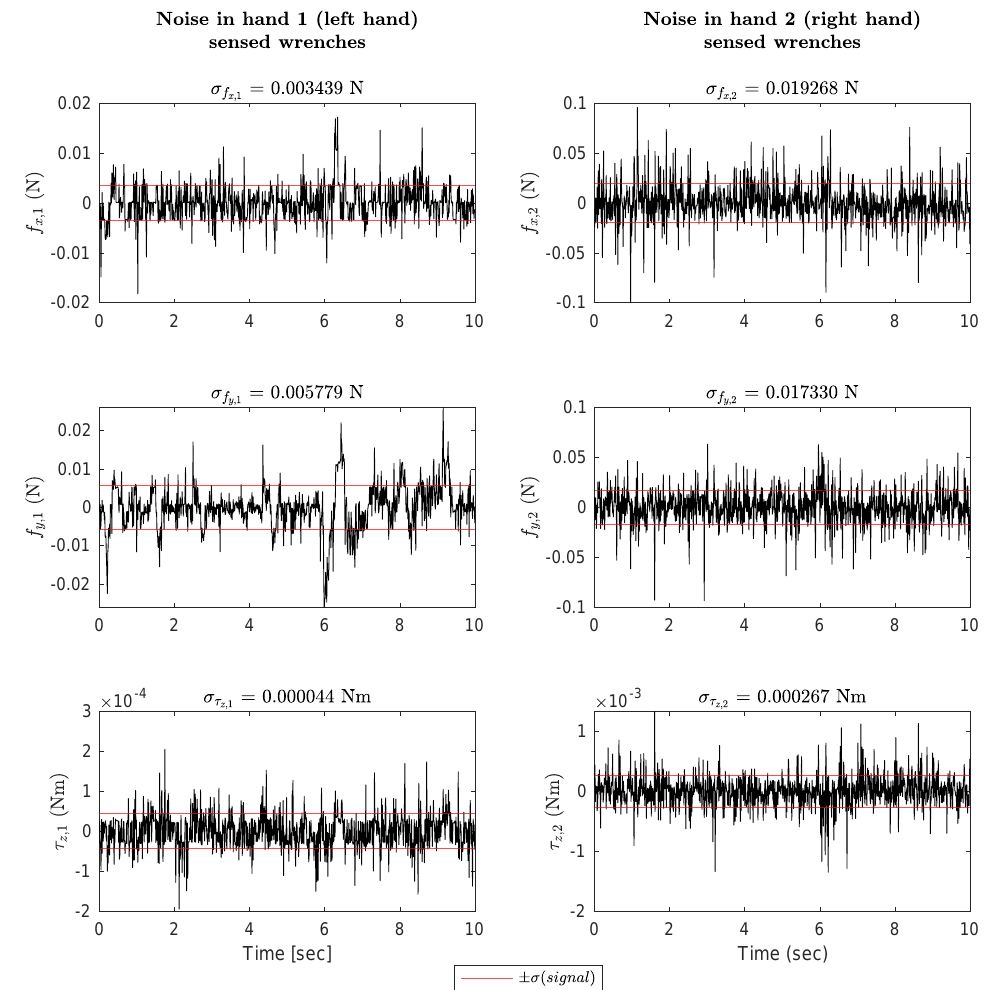
Figure A2. The force/torque sensor on both robot hands was kept static under no-load conditions, and data were collected for 10 s at 1000 Hz. The signals are portrayed here, along with the associated standard deviation per signal computed from the covariance matrix Σ W